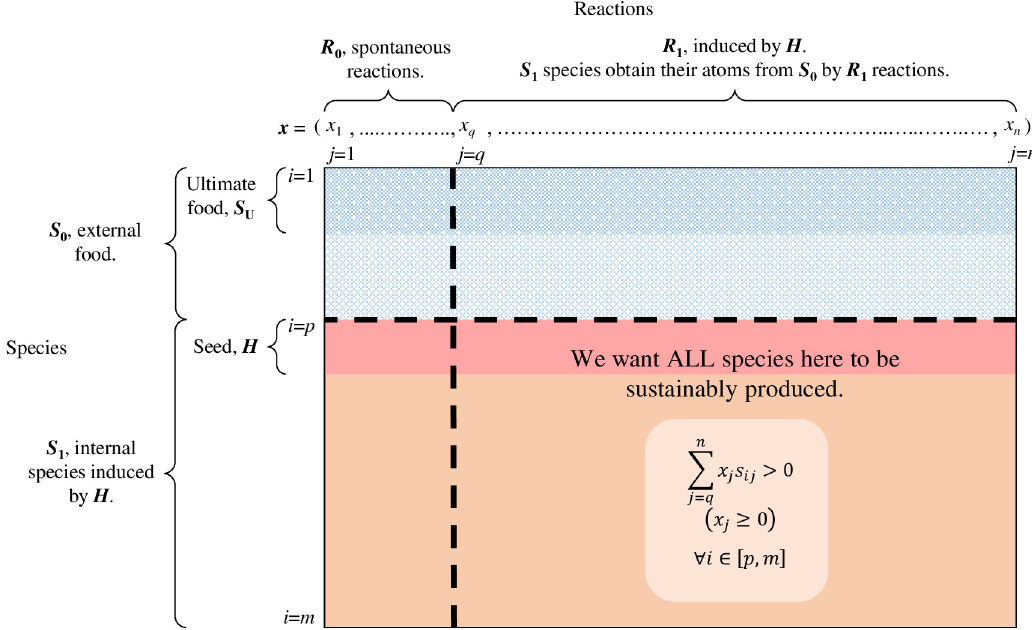
Fig 2. Detecting a SDAS. Based on network expansion, a stoichiometric matrix is divided into four segments. Network expansion from the ultimate food generates the upper left segment, consisting of external food available for a potential SDAS and reactions among these food species. Then adding the candidate seed triggers further network expansion, generating the other three segments. The lower left segment consists only of zeroes because the reactants and products of corresponding reactions are all external. The upper right segment represents the external food involved in the reactions induced by the seed; because external food is assumed freely available, detection of a SDAS does not rely on this segment. The lower right segment represents internal species and reactions induced by the seed; for these internal species to be produced with excess such that they have the potential to sustain dilution, the seed-induced reactions must find a way to synthesize all internal species by consuming external food.